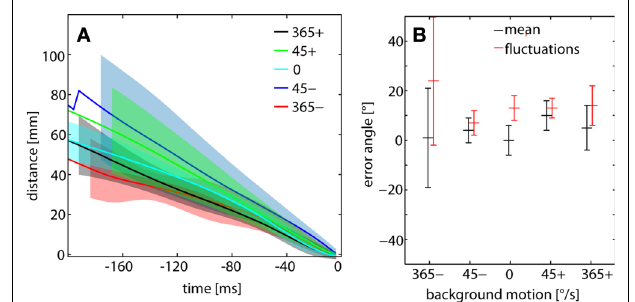
FIGURE 6 | (A) Distance between chasing fl y and target and (B) error angle of the target determined for C-chases for the different background conditions. (A) Mean time course of the fl ies’ distance to the target for the last 200 ms before catching the target. The data were aligned to the end of the fl ight episode (i.e. the catch represents time 0 ms). Colored lines represent the mean time course; similarly colored shaded areas depict the respective standard error of the mean. For the sake of clarity, these areas are shortened differentially. Mean and standard deviation were calculated across fl ies. n = 36 chases, total fl ight time = 7200 ms. Color code of background conditions given in the inset. (B) Mean error angle ( black ) obtained from a sample of fl ies. The average (time-dependent) fl uctuations of the target on the eyes ( red ) range between 7 ° and 24 ° . Chases: n = 36, total fl ight time = 10648